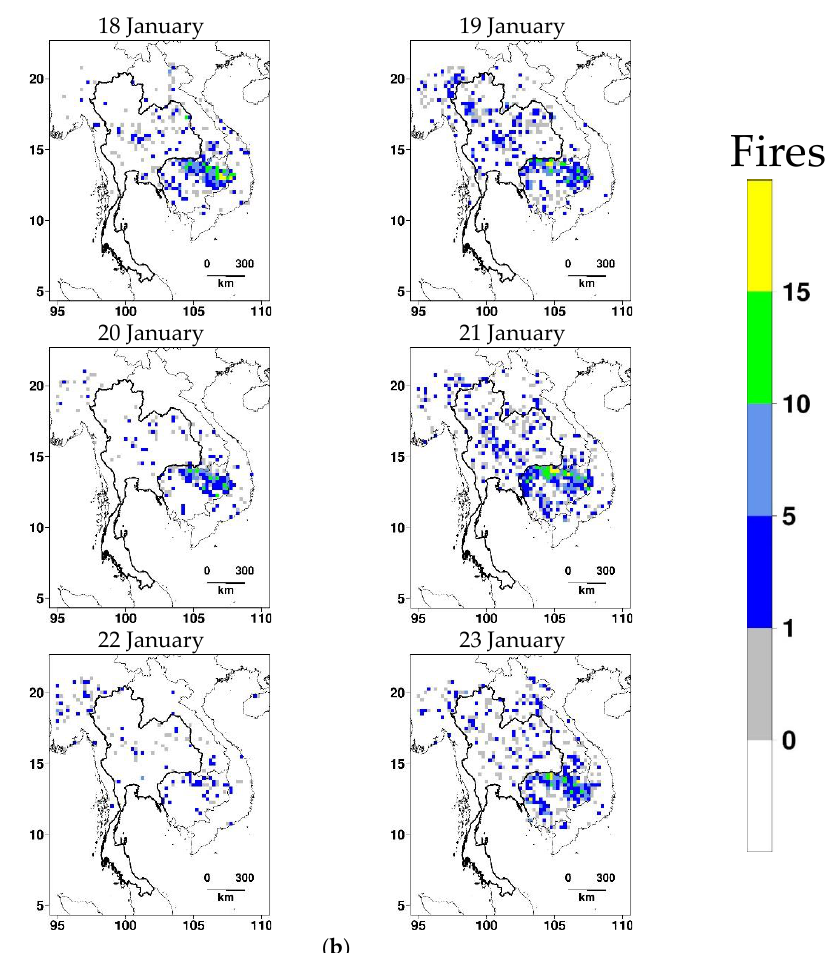
Figure 6. Daily fire counts on 0.25° cells during ( a ) Episode 20 and a few days afterward; ( b ) Episode 25 and a few days afterward.